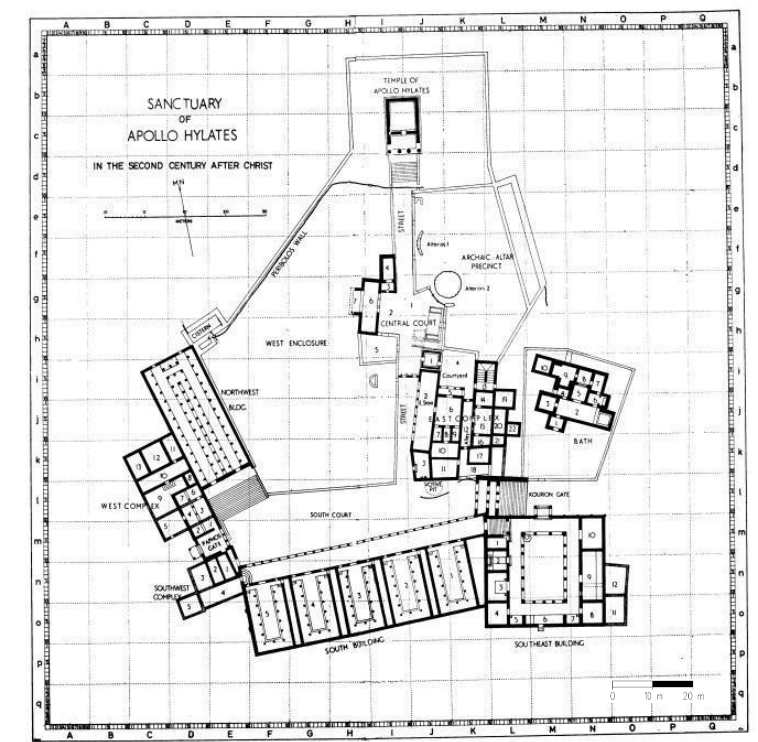
Figure 1. Plan of archaeological area of the Sanctuary of Apollo Hylates, Kourion (Scranton 1967, plan